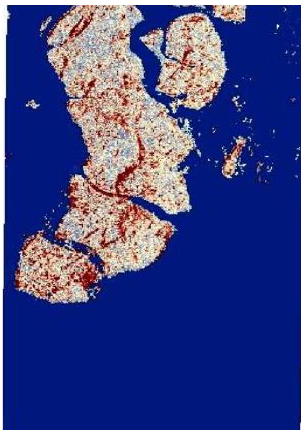
Figure 12: Generated high definition